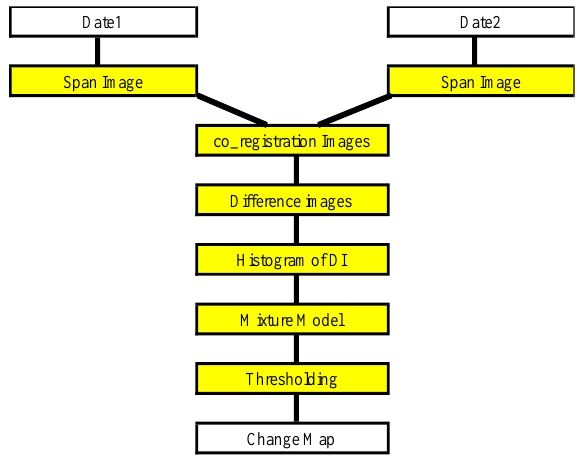
Figure 1. An overview of the proposed